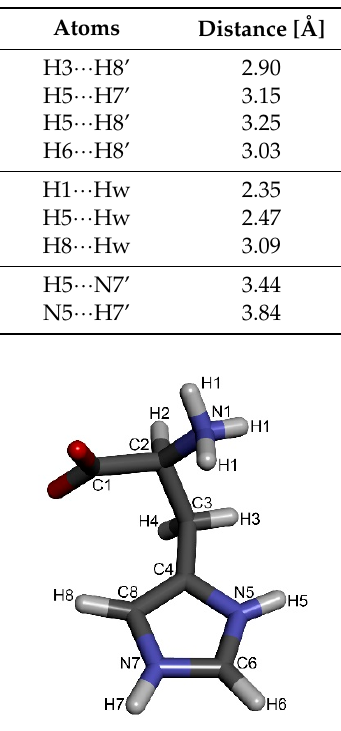
Table 1. Intermolecular interactions detected in the crystal structure of L -histidine·HCl·H 2 O. Atoms